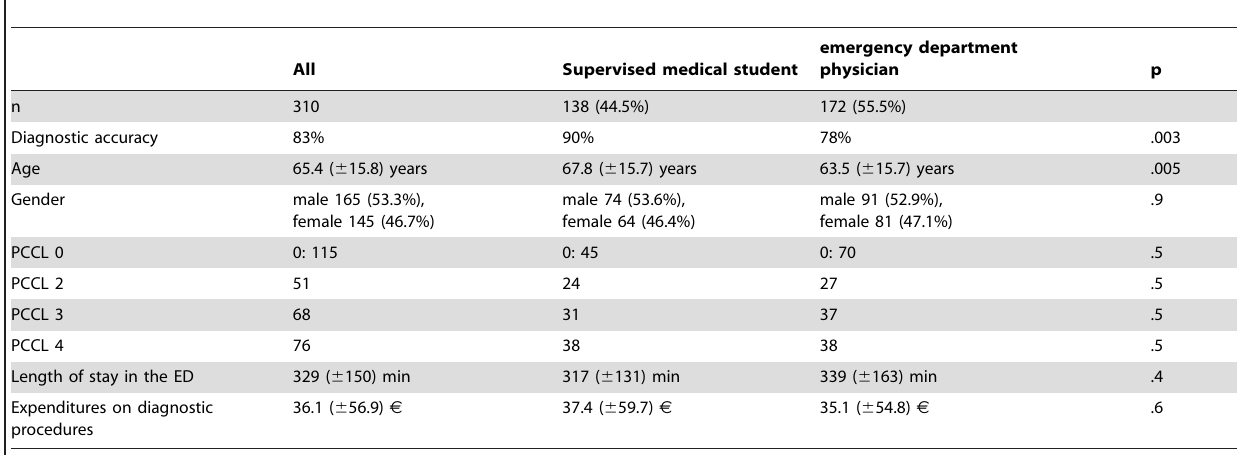
Table 1. Characteristics of the patients seen by supervised medical students and emergency department physicians.